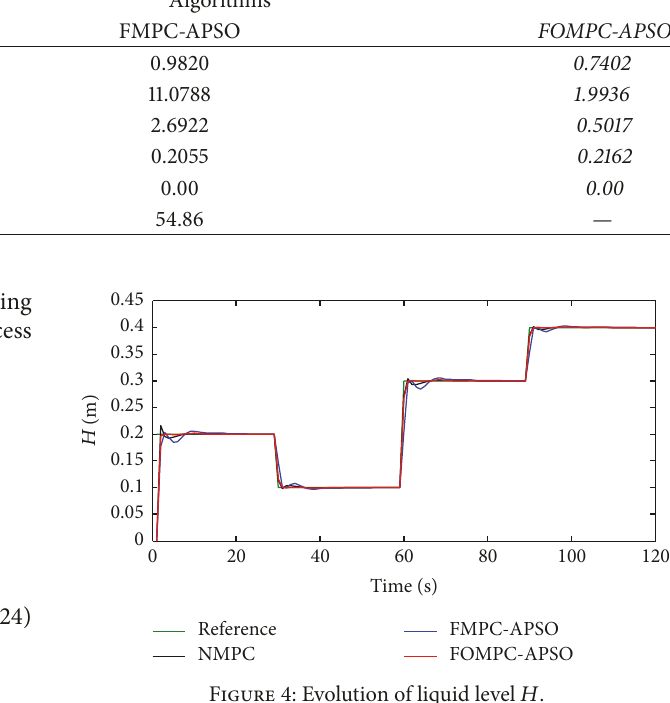
Figure 4: Evolution of liquid level 𝐻 .